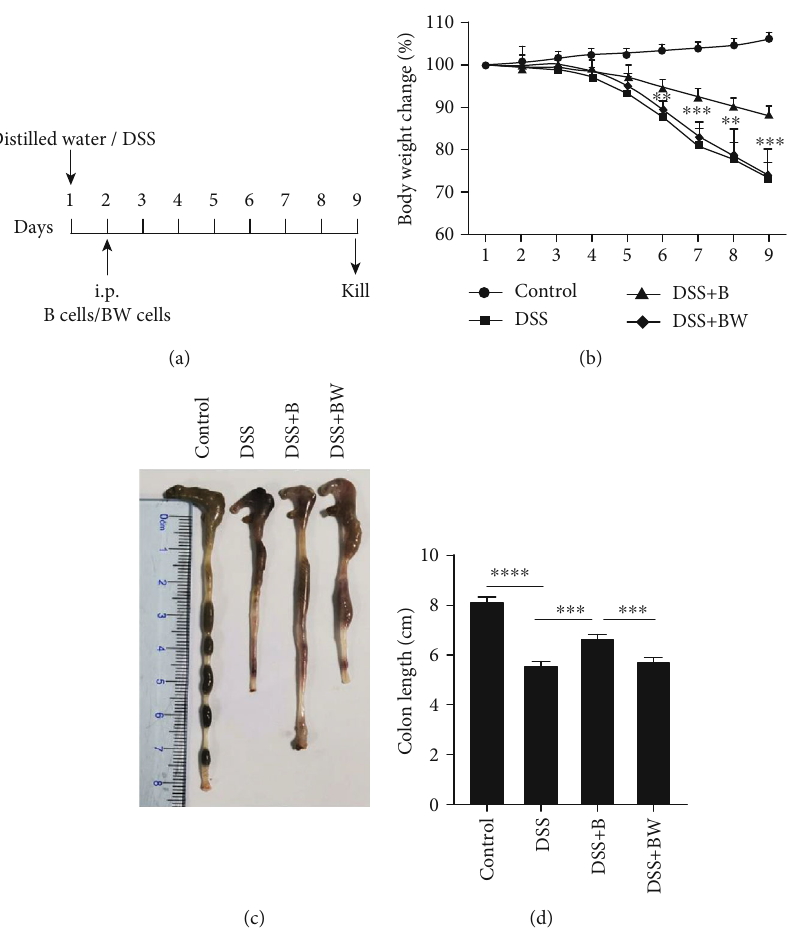
Figure 1: E ff ect of Wogonin on B cells in mouse with acute colitis induced by DSS. The drinking water containing 5% DSS was administered for one day, followed by intraperitoneal injection of B cells (DSS+B group) or Wogonin-pretreated B cell (DSS+BW group) on the second day and sacri fi ced on the ninth day. (a) The procedure of animal model in C57BL/6 mice. (b) The body weight changes of mice after DSS induction of colitis. ∗∗ P < 0 : 01 ; ∗∗∗ P < 0 : 001 for comparison with the DSS+B group. (c) Representative colonic length of mice was measured in four groups. (d) Quanti fi cation of colonic length of mice in four groups was shown. Data are presented as mean ± SD ( n = 6 per group). ∗∗∗ P < 0 : 001 ; ∗∗∗∗ P < 0 : 0001